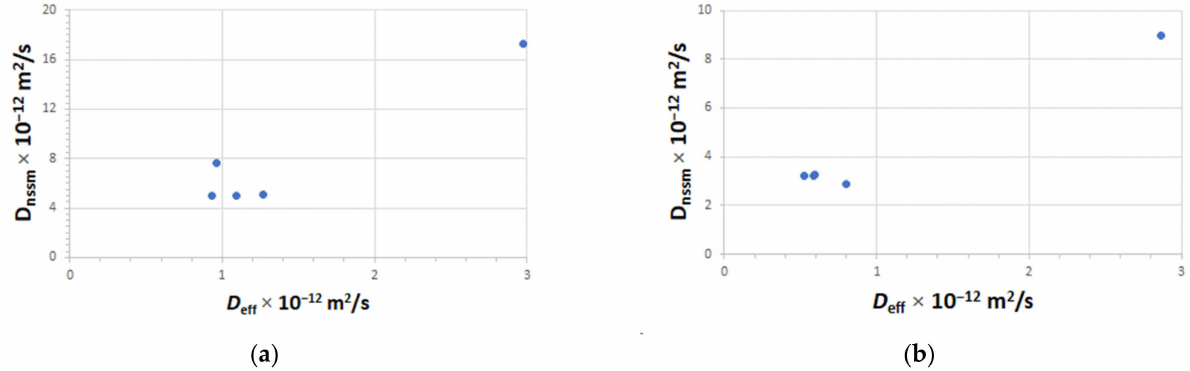
Figure 8. Chloride diffusion coefficient versus migration coefficient of concretes made with ternary cements: ( a ) A-Concrete; ( b )